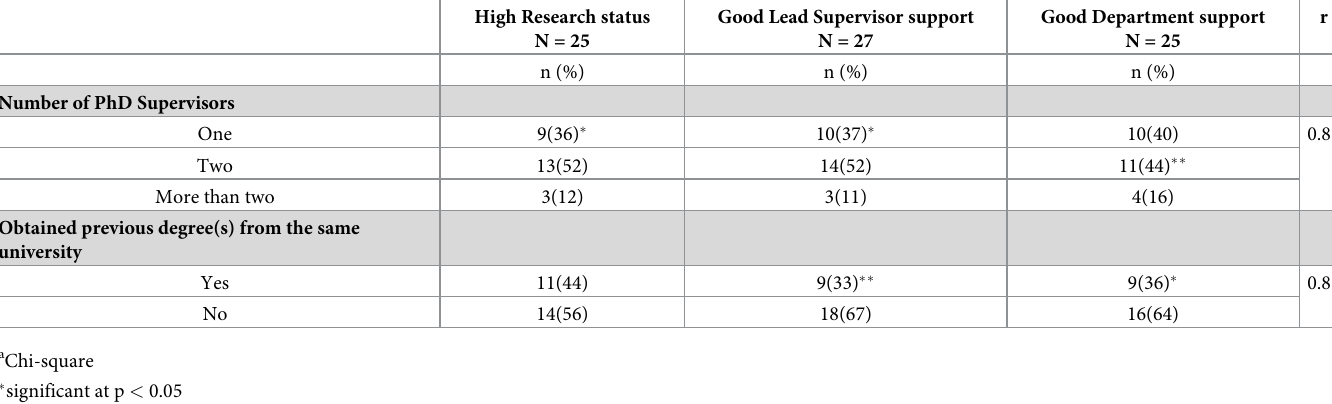
Table 3. Associations between the independent variables, the research status, lead supervisor support and department